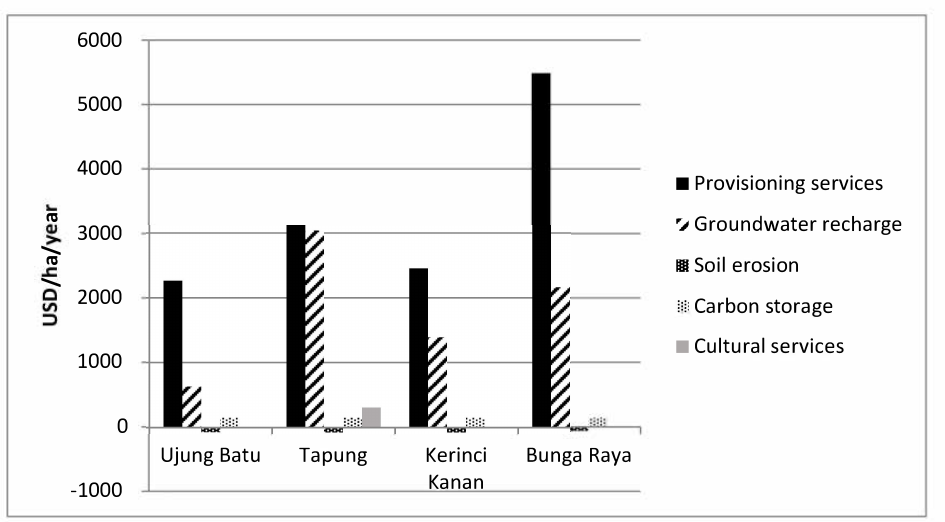
Figure 2. Summary of economic value of ecosystem services and dis-services provided by oil palm landscapes in Bunga Raya, Kerinci Kanan, Tapung, and Ujung Batu. The provisioning services category includes oil palm fruits, rubber, coconut, bamboo, areca nuts, cacao, rice, cattle, and